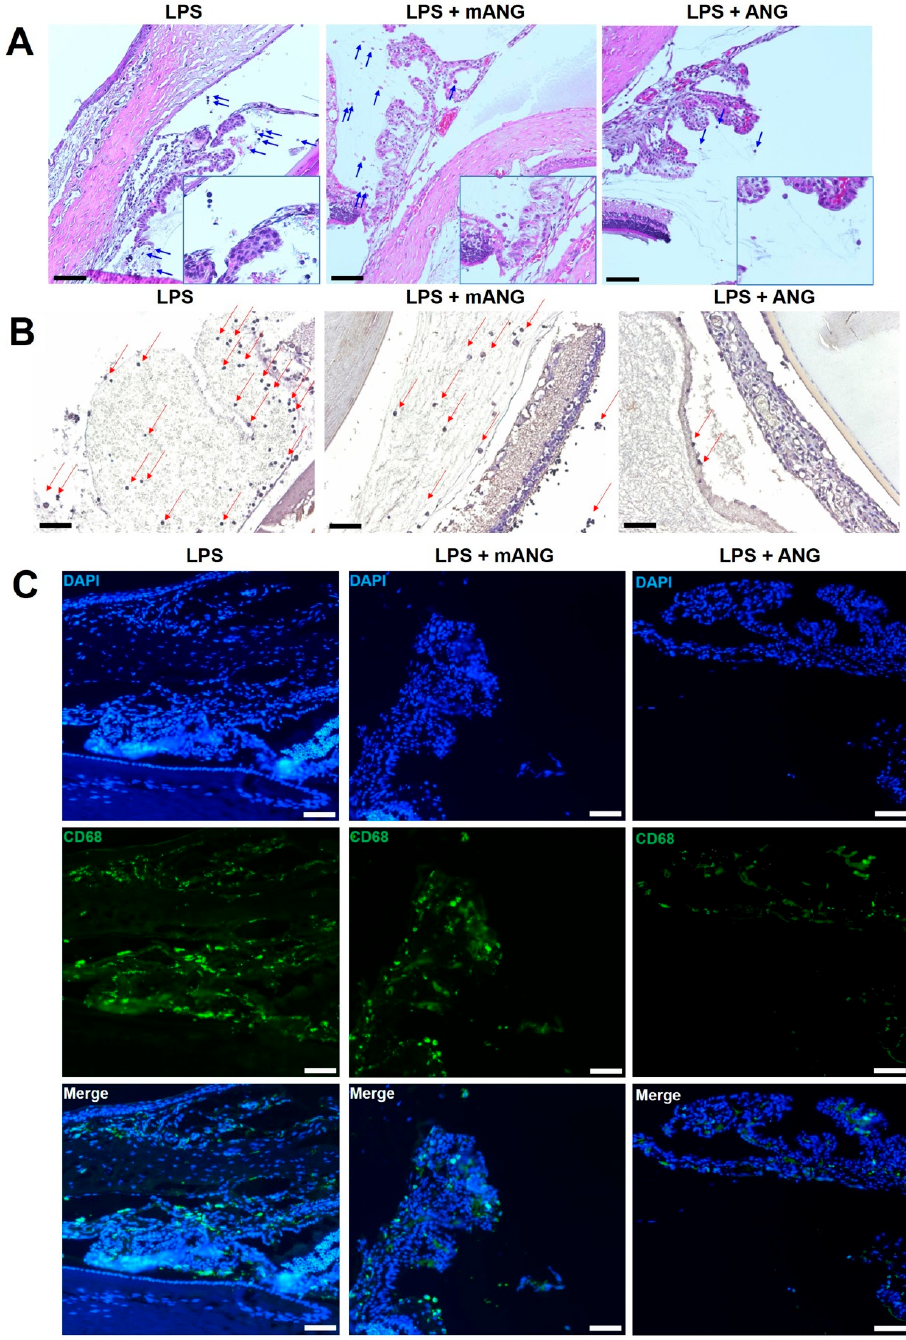
Figure 1. Histopathological evaluation of EIU in rats. ( A ) The eyes were cryosectioned and were stained with H&E. Representative sections are shown. Arrows show the infiltration of inflammatory cells (leukocytes) in the anterior chamber. Accumulation of fibrinous membrane is shown in both LPS and LPS + mANG eyes. ( B ) Immunohistochemical staining on frozen sections of the ciliary bodies. Arrows indicate the expression of macrophage marker CD11B. ( C ) The expression of CD68 was determined by immunofluorescent localization (green). Fluorescent staining of the nuclei of fixed cells is shown as the control in 4 ′ ,6 ‐ diamidino ‐ 2 ‐ phenylindole (DAPI) (blue). The same sections were localized for CD68 in all treatment groups, and the two di ff erent stains were merged to show the relative change in expression. All scale bars = 200 µ m ( n =